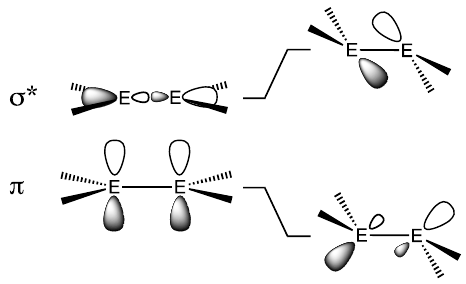
Figure 2. Second-order Jahn–Teller π – σ * orbital interaction accounting for the trans -bent distortion in the analogues of alkenes of the heavy group 14 elements.